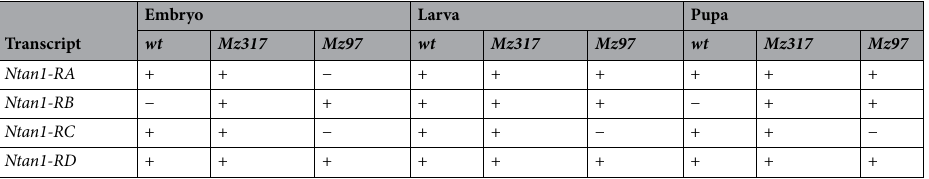
Table 2. Summary of the results obtained in the gene expression analysis by RT-PCR of the Ntan1 transcripts in different development stages (embryo, larva and pupa) in different genotypes. The genotypes tested are: Canton-S (wt), Mz317-Gal4 (Mz317) and Mz97-Gal4,UAS-Stinger (Mz97). Negative symbol (−) indicates total absence of gene expression and positive symbol (+) indicates gene expression of the Ntan1 transcripts.